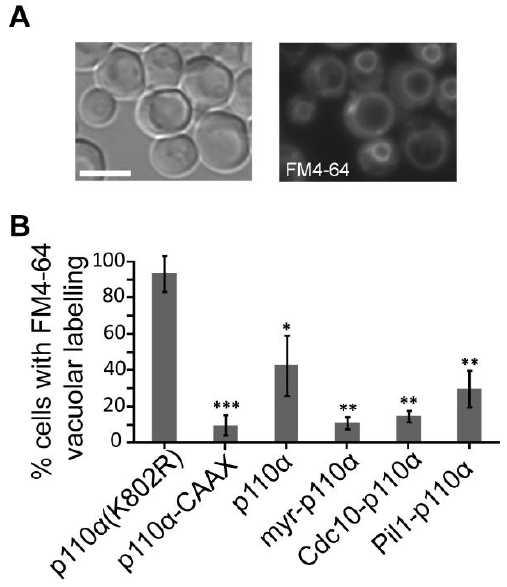
FIGURE 2: Endocytic fitness of non-targeted and various PM- targeted p110α versions. (A) Bright field (left image) or fluores- cence microscopy (right image) representative images of typical FM4-64 vacuolar staining in YPH499 cells expressing the kinase- dead mutant p110α(K802R), 60 min after the addition of the vital dye. (B) Graphical representation of the percentage of cells (n ≥ 300) showing the aforementioned vacuolar staining pattern when expressing p110α(K802R), p110α-CAAX, p110α, myr-p110α, Cdc10-p110α and Pil1-p110α. Results displayed in the graphs correspond to the mean of three biological replicates performed on different clones. Error bars represent the standard deviation (SD). Asterisks (*, **, ***) indicate a p-value < 0.05, < 0.01, < 0.001 respectively by the Student´s t-test, referred to p110α(K802R). Scale bars indicate 5